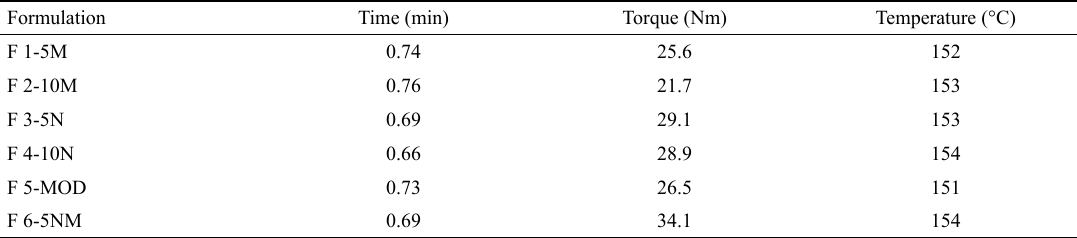
Table 2. Gelation data of the PVC compounds with micro and nano-CaCO